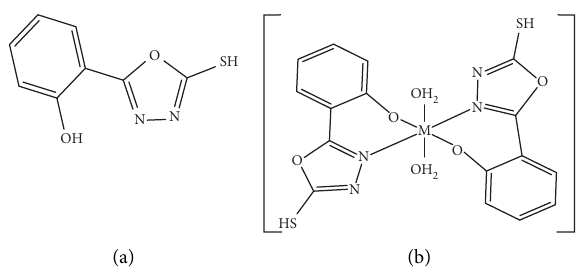
Figure 1: Structure of the 2-(5-mercapto-1,3,4-oxadiazol-2-yl) phenol (MODP) (a) and complexes